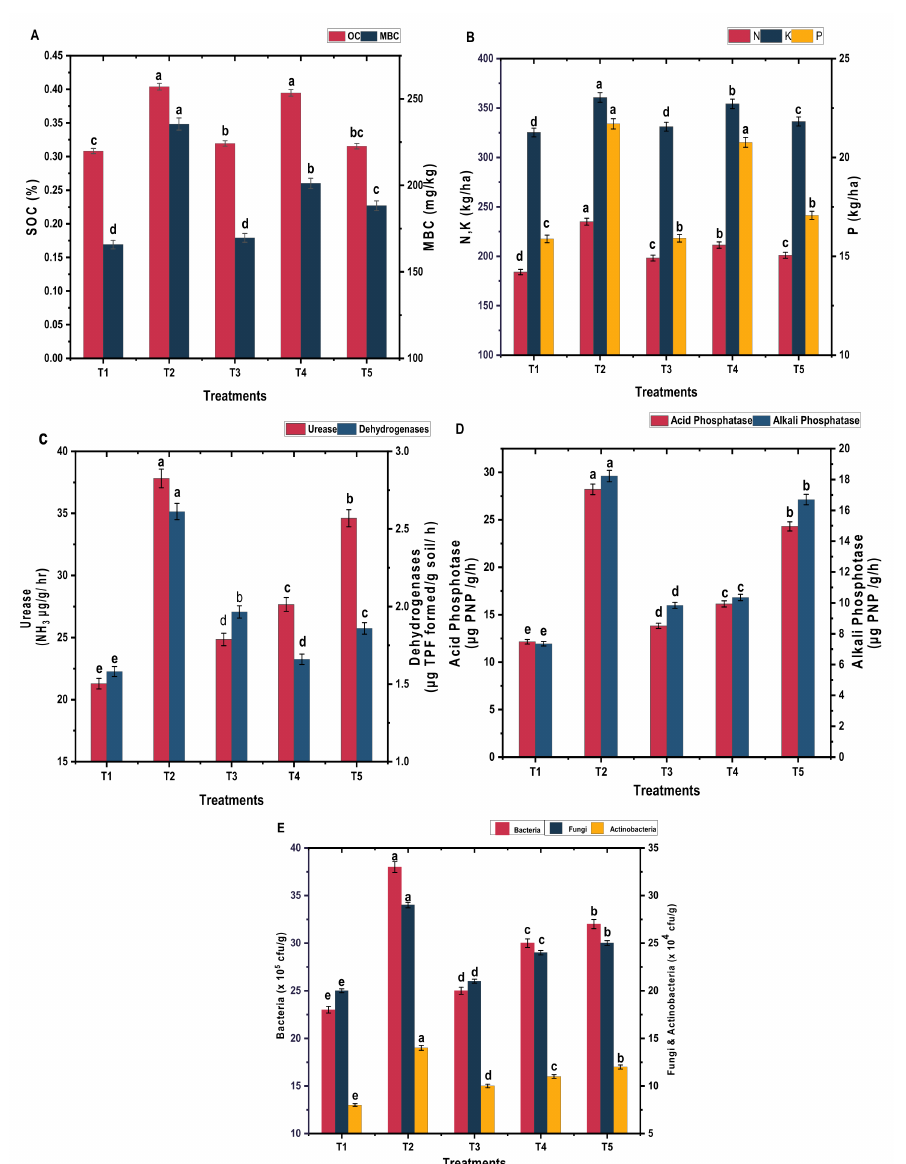
Figure 4. ( A ) Carbon dynamics, ( B ) soil nutrient status, ( C ) urease and dehydrogenases, ( D ) acid phosphatase and alkali phosphatase and ( E ) soil microbial population in EFY-based